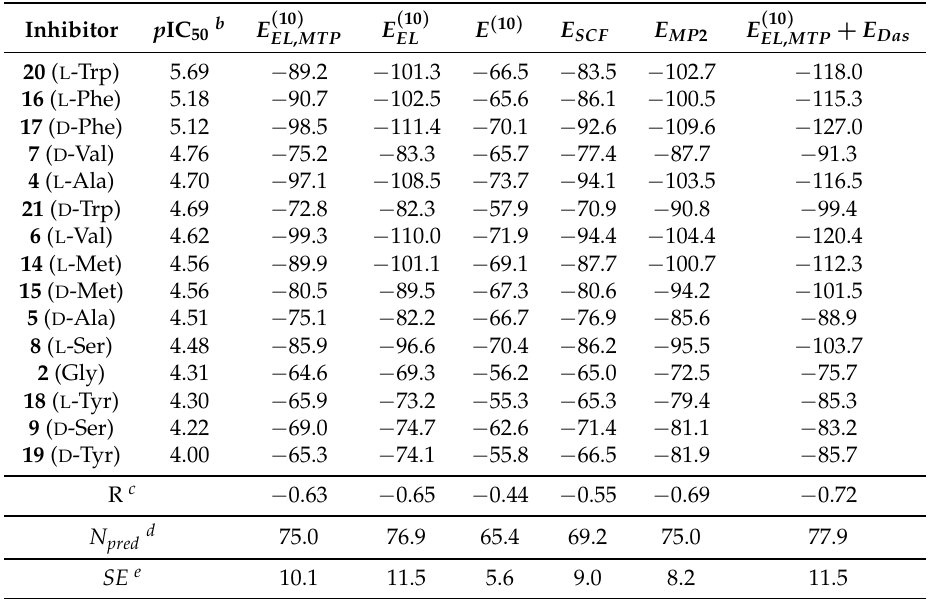
Table 2. Total EphA2-inhibitor interaction energy a at the consecutive levels of